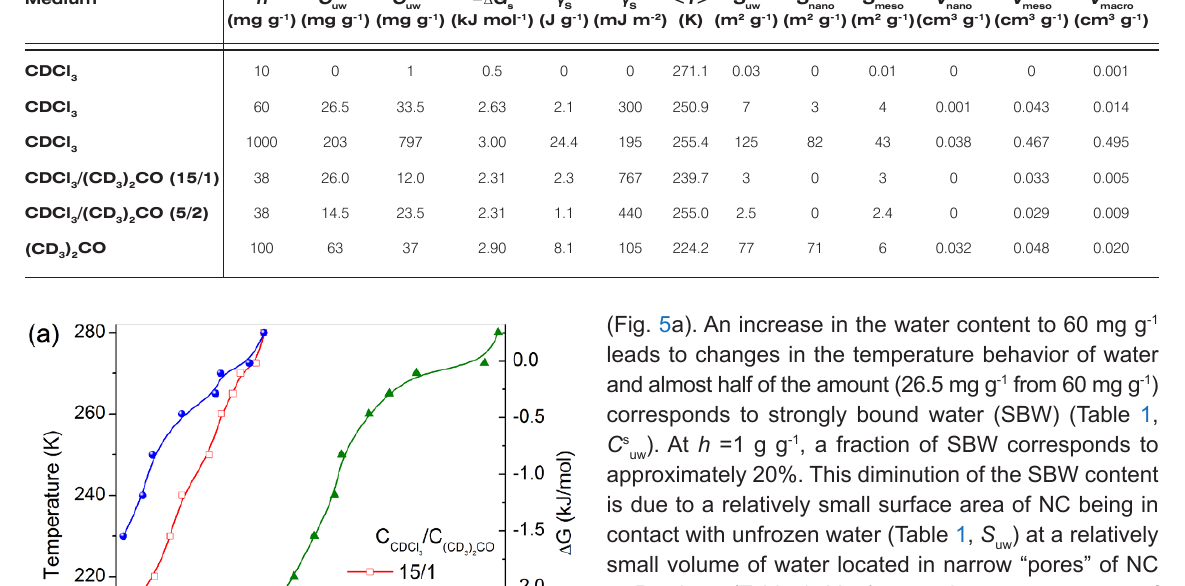
Table 1. Characteristics of unfrozen water bound to nitrocellulose in different media and at different hydration degree.